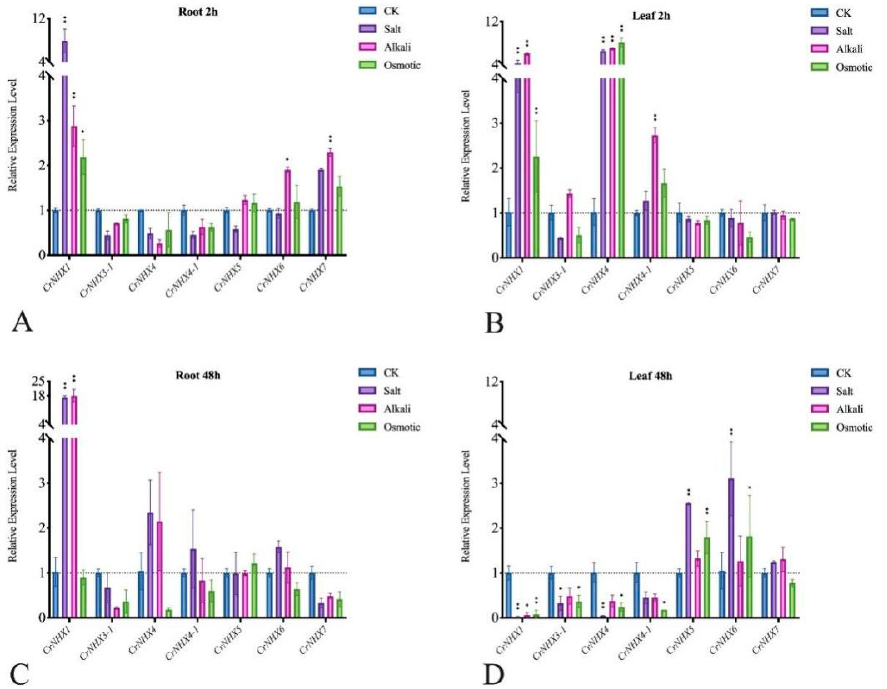
Figure 9. Quantitative RT-PCR detection of the expression levels of the eight CrNHX s responding to different stresses (600 mM NaCl, 150 mM NaHCO 3 , and 300 mM mannitol) in C. rosea seedlings of ( A ) root samples under 2 h stress challenges; ( B ) leaf samples under 2 h stress challenges; ( C ) root samples under 48 h stress challenges; and ( D ) leaf samples under 48 h stress challenges. Relative expression values were calculated using the 2 −Δ Ct method with the housekeeping gene CrEF- ɑ as a reference gene. Bars show the mean values ± SD of n = 3–4 technical replicates. The significance level was defined as * ( p < 0.05) and ** ( p < 0.01).